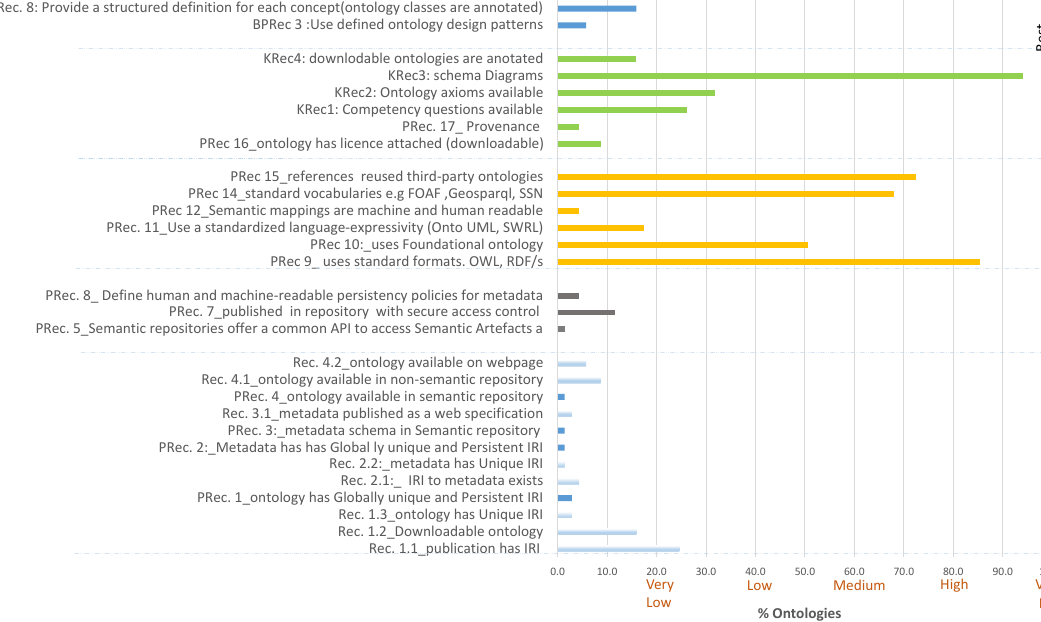
Figure 4. Adherence to FAIR principles for Ontology Artefacts within the Disaster Management Domain